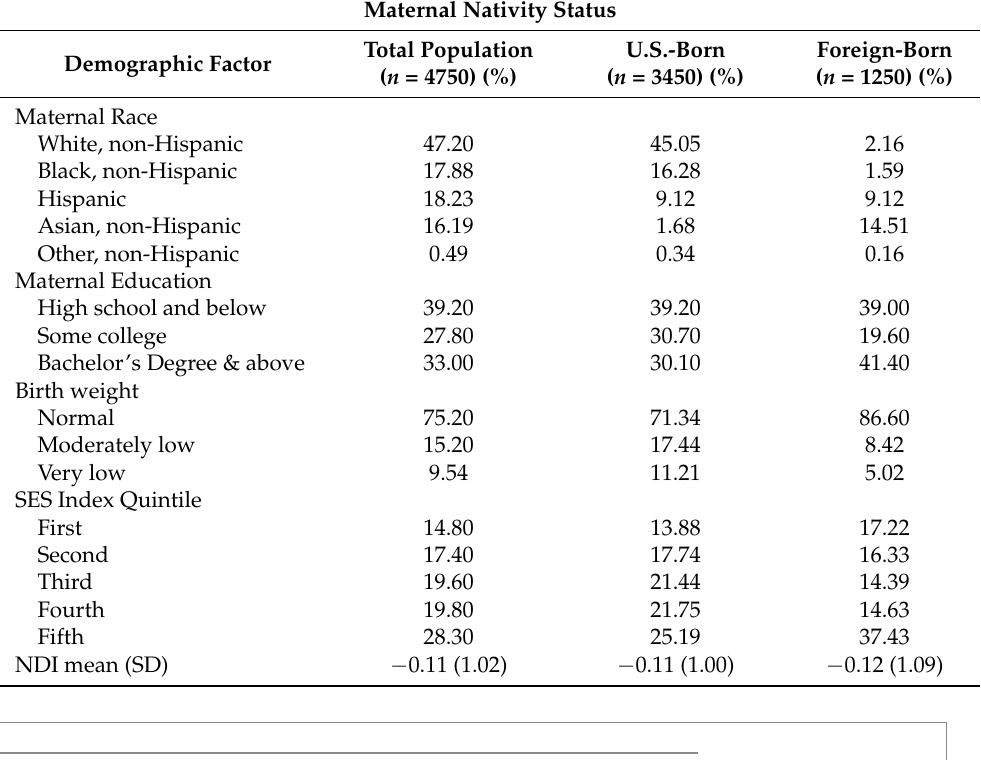
Table 1. Demographic characteristics in the ECLS-B study population and stratified by maternal nativity status (2001 birth cohort).